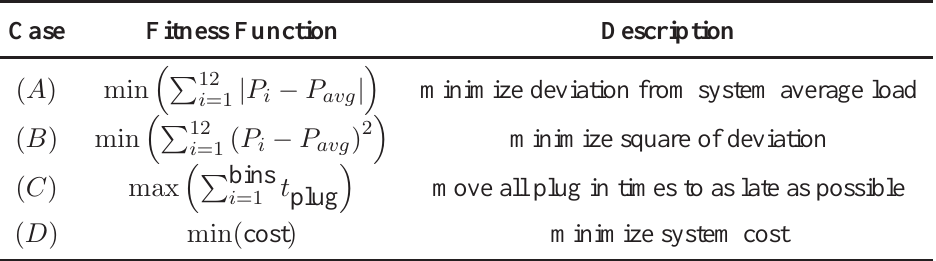
Table 3. Fitness